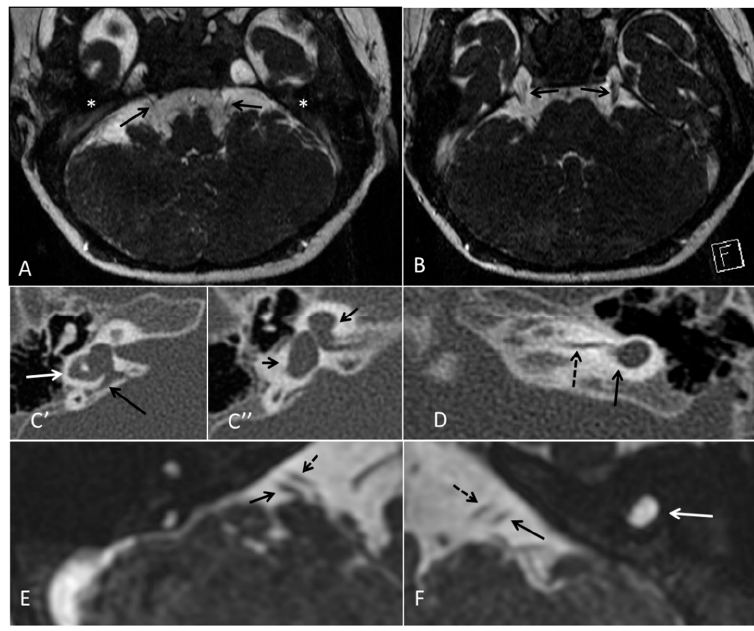
Figure 1. Axial T2 high resolution 3D sequence on the internal auditory canal (IAC) in patient 1 ( A,B ) show absence of membranous labyrinth in both petrous bones (*) with presence of VII nerves (arrows in A ) and V nerves (arrows in B ). Axial CT petrous bone in patient 7 shows incomplete partition type 1 malformation on the right ( C’ , C’ ’), characterised by dysplastic lateral semicircular canal (white arrow in C’ ), dilated vestibular aqueduct (black arrow in C’ ), dilated cochlea and vestibule without visualisation of the modiolus (arrows in C’’ ). In the same patient on the left ( D ) there is a rudimentary otocyst (arrow) with very narrowed IAC (dotted arrow). Axial T2 high resolution 3D sequence on the IAC in patient 7 ( E , F ) demonstrates presence of VII (dotted arrow) and VIII (black arrow) cranial nerves in the ponto-cerebellar angle on both sides. The rudimentary otocyst on the left is also noted ( F , white